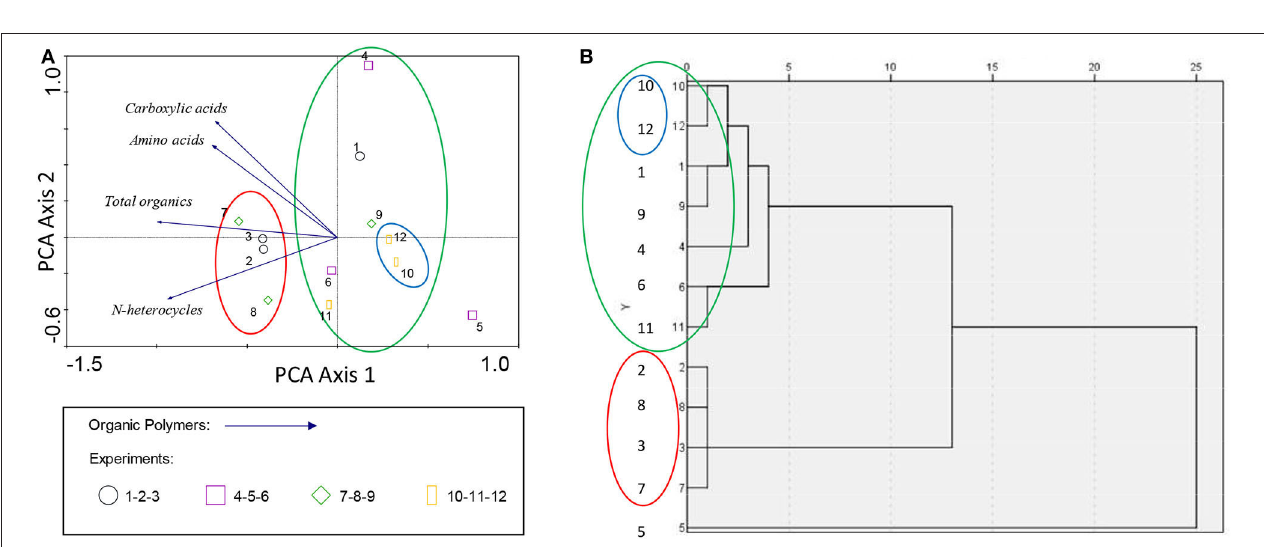
FIGURE 6 | Total polymers statistical analysis. (A) PCA plot based on the relative proportions of amino acids, carboxylic acids, N-heterocycles, and total organic obtained in every experiment for the full polymers. Relative proportions of the different compounds are indicated by arrows. The observed clusters are indicated by circles. (B) Hierarchical dendrograms calculated using PCA components. Experiments are represented by their numbers. The obtained clusters are designated by